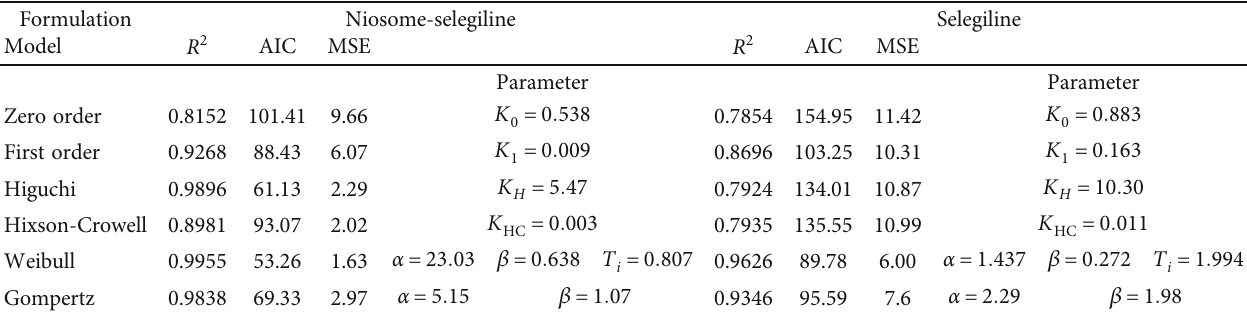
Figure 6: (a) Percentage of hemolysis induced by niosomes at various concentrations. Cumulative drug release in (b) SIF media (pH 6.80), (c) SGF media (pH 1.2), and (d) bu ff er solution (pH 7.4). Table 4: R2, Akaike ’ s information criterion (AIC) and mean squared error (MSE) parameters from fi tting release data of niosome-selegiline and free-selegiline on various